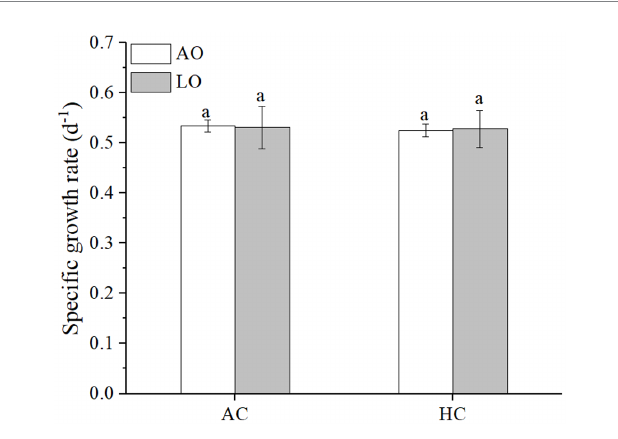
FIGURE 1 The specific growth rates of Trichodesmium . erythraeum IMS101 grown and measured after it acclimated for 16 days (12 generations) to different combinations of p CO 2 and p O 2 (AO, ~245 μ M; LO, ~60 μ M; AC, ~12 μ M; HC, ~32 μ M. LO and HC refer to lowered p O 2 and elevated p CO 2 ). The values are indicated as the means ± SD for independent cultures ( n = 6) at each treatment. The same letters above the bars indicate no significant ( p < 0.05) differences among the treatments.